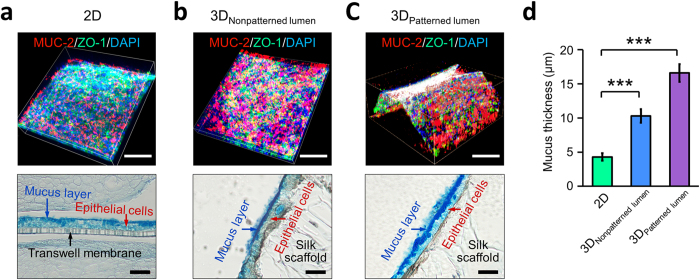
3D silk scaffolds increase the thickness of the mucus layer of the intestinal epithelial cells.(a–c) Confocal microscopy images of immunostaining of MUC-2, ZO-1, and DAPI of Caco-2/HT29-MTX cultured on 2D transwells (a), and non-patterned (b) and patterned (c) 3D silk scaffolds 21 days post cell seeding. MUC2 is visualized as red, ZO-1 as green, and DAPI as blue. Scale bar = 200 μm. (d,e) Light microscopy of toluidine blue stained frozen sections across the transwell inserts (d), non-patterned (e) and patterned (f) 3D silk scaffolds. Outer mucus layers on 3D scaffolds are pointed by the black arrowheads, while inner mucus layers are pointed by yellow arrowheads. Scale bar = 100 μm. (g) Measurement of mucus thickness yielded by the epithelium grown on 2D and 3D systems. n = 6 in each group, ***p < 0.001.